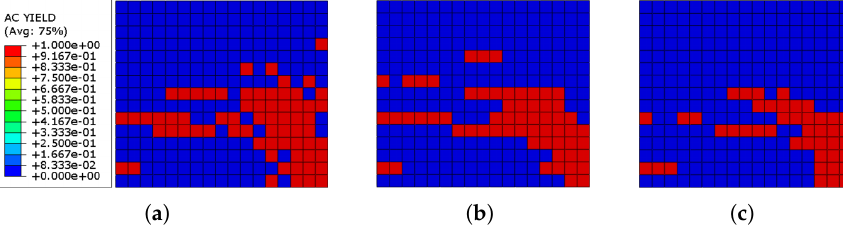
Figure 19. AC yield distribution in the URM reinforced with ECC sheets: ( a ) ECC thickness = 20 mm; ( b ) ECC thickness = 25 mm; ( c ) ECC thickness = 30 mm.